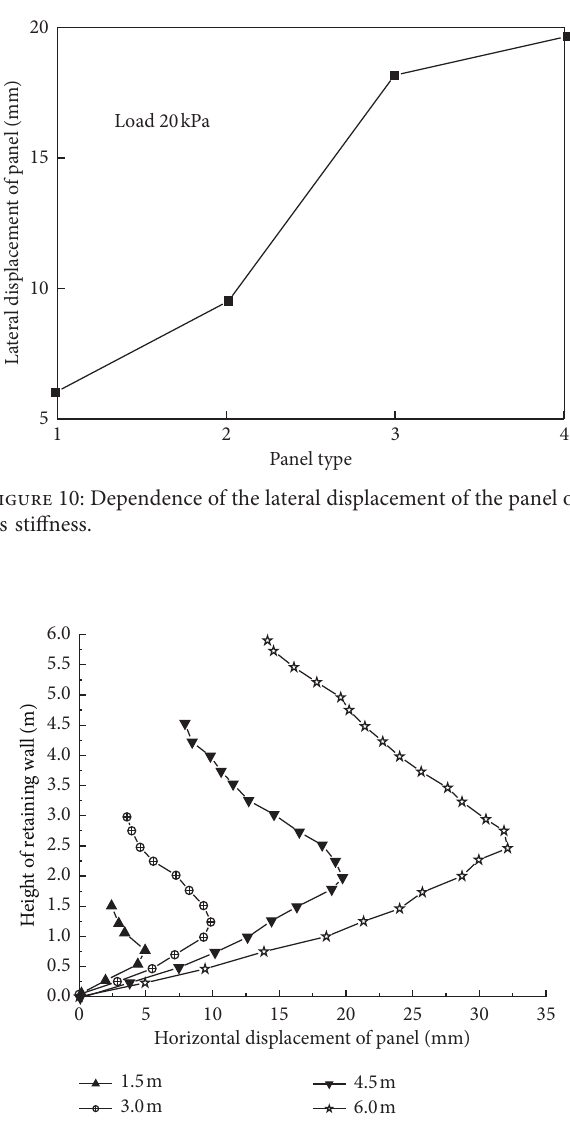
Figure 11: Horizontal displacement of different retaining walls.